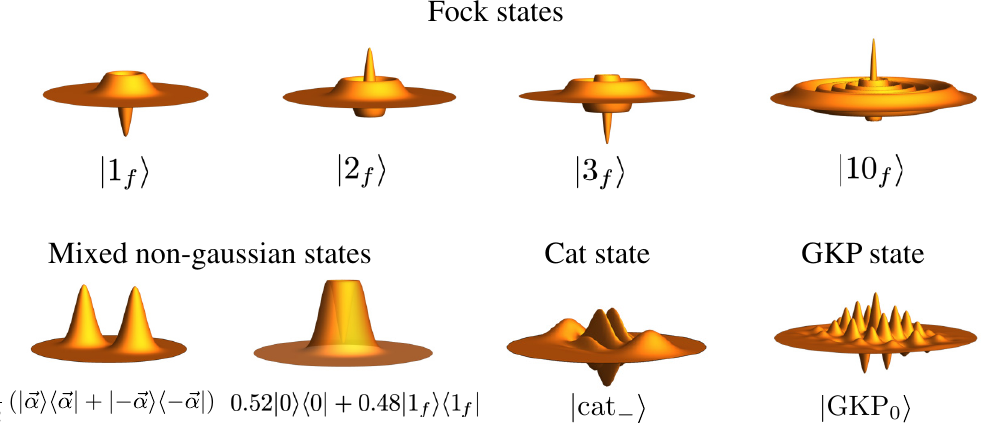
FIG. 2. Several examples of Wigner functions for single-mode non-Gaussian states. The Wigner functions for the Fock states are obtained from Eq. (118) and the mixture of a Fock state and a vacuum is given by Eq. (124). The mixture of coherent states is expressed in Eq. (122) where we set (cid:9)(cid:13) α (cid:9) = 4. The Wigner function for the cat state is given by Eq. (126) where we choose (cid:9)(cid:13) α (cid:9) = 6. Finally, for the GKP state, Eq. (130), we numerically integrated a wave-function expression of the state with s = 2 and δ = 0.3 to obtain the Wigner